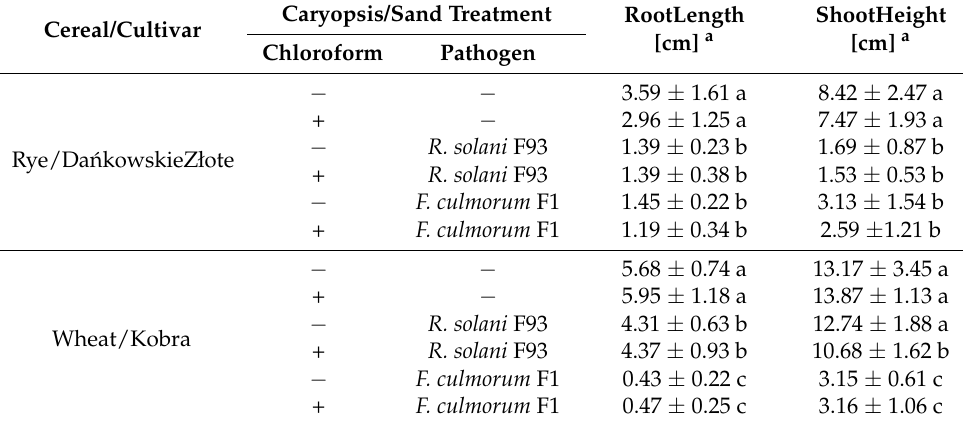
Table 2. The effect of chloroform treatment of rye and wheat caryopses on the development of their seedlings in the presence of fungal